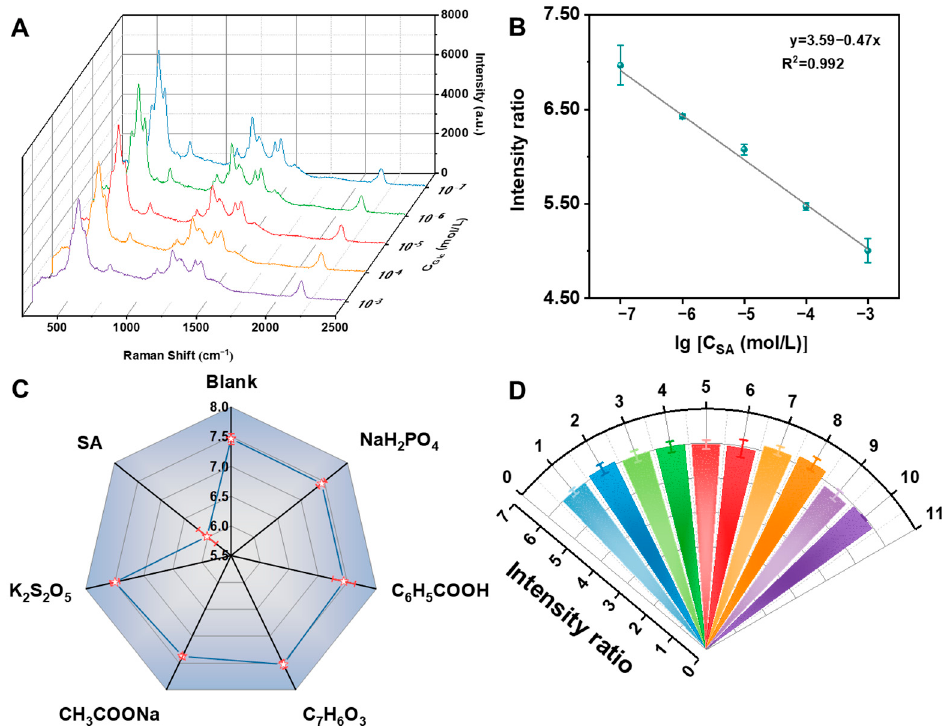
Figure 5. ( A ) The SERS spectra of this system at various concentrations of sorbic acid (10 − 3 –10 − 7 mol/L). ( B ) Calibration plot based on the Raman intensity of 585 cm − 1 /2185 cm − 1 . ( C ) The SERS response of 585 cm − 1 /2185 cm − 1 to 10 µ M of sorbic acid and 0.1 mM others. ( D ) The SERS intensity ratio of 585 cm − 1 /2185 cm − 1 obtained from 10 sets and measured three times in parallel with 10 µ M glucose solution.